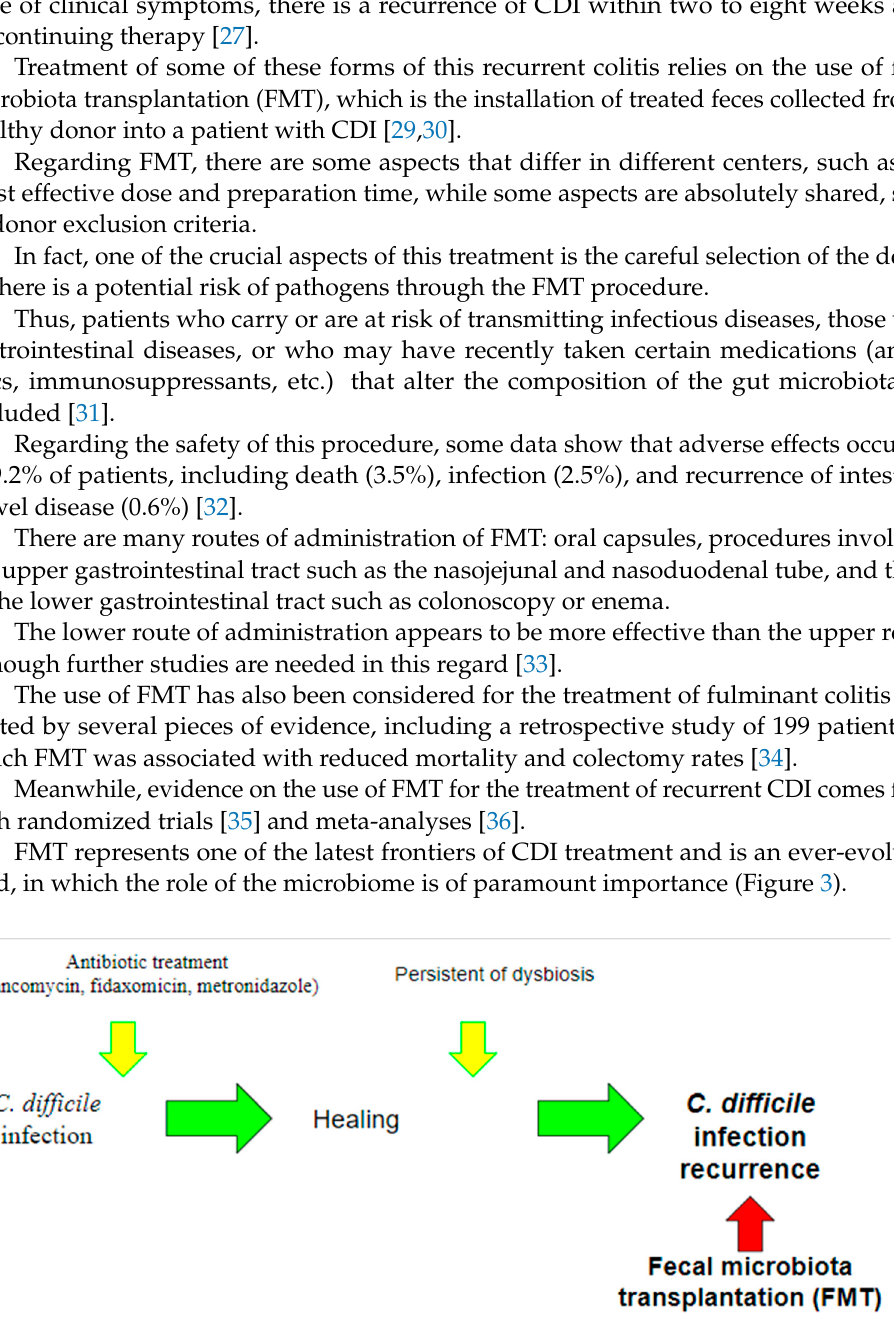
Figure 3. Use of fecal microbiota transplantation (FMT). Currently, the use of FMT is indicated for the treatment of recurrent CDI, in which recurrent infections occur due to the persistence of dysbiosis. The aim of this treatment is precisely to intervene by restoring the balance of the gut microbiota.